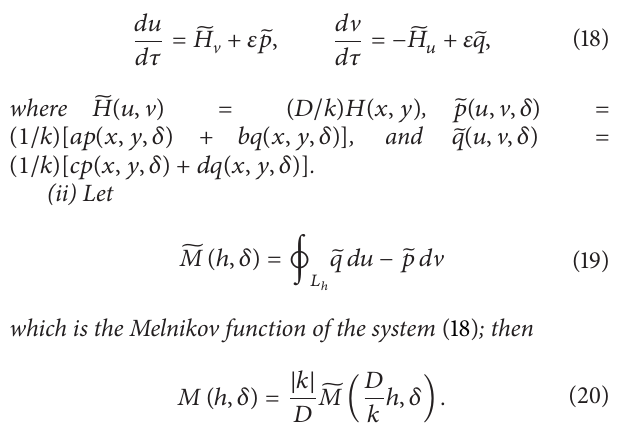
are 4 families of periodic orbits 𝐿 ℎ 𝑖 inside the 2-polycycle 𝐿 𝑖 , defined by 𝐻(𝑥, 𝑦) = ℎ for ℎ ∈ (𝛼 1 , 𝛽) , 𝑖 = 1, 3, 5, 7 , and 4 families of periodic orbits 𝐿 ℎ 𝑗 inside the 2-polycycle 𝐿 𝑗 , defined by 𝐻(𝑥, 𝑦) = ℎ for ℎ ∈ (𝛼 2 , 𝛽) , 𝑗 = 2, 4, 6, 8 .